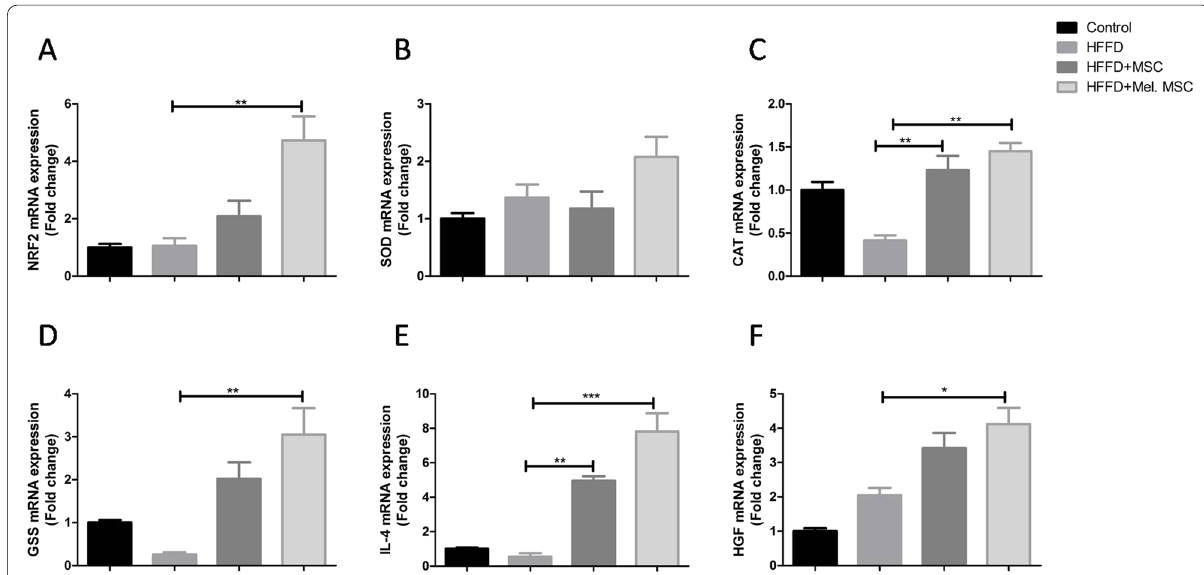
Fig. 7 m-RNA expression of markers A Nrf2 , B Sod , C Cat , D Gss , E Il-4 , and F Hgf in hepatic tissue of control, HFFD, HFFD MSC. Data expressed as mean